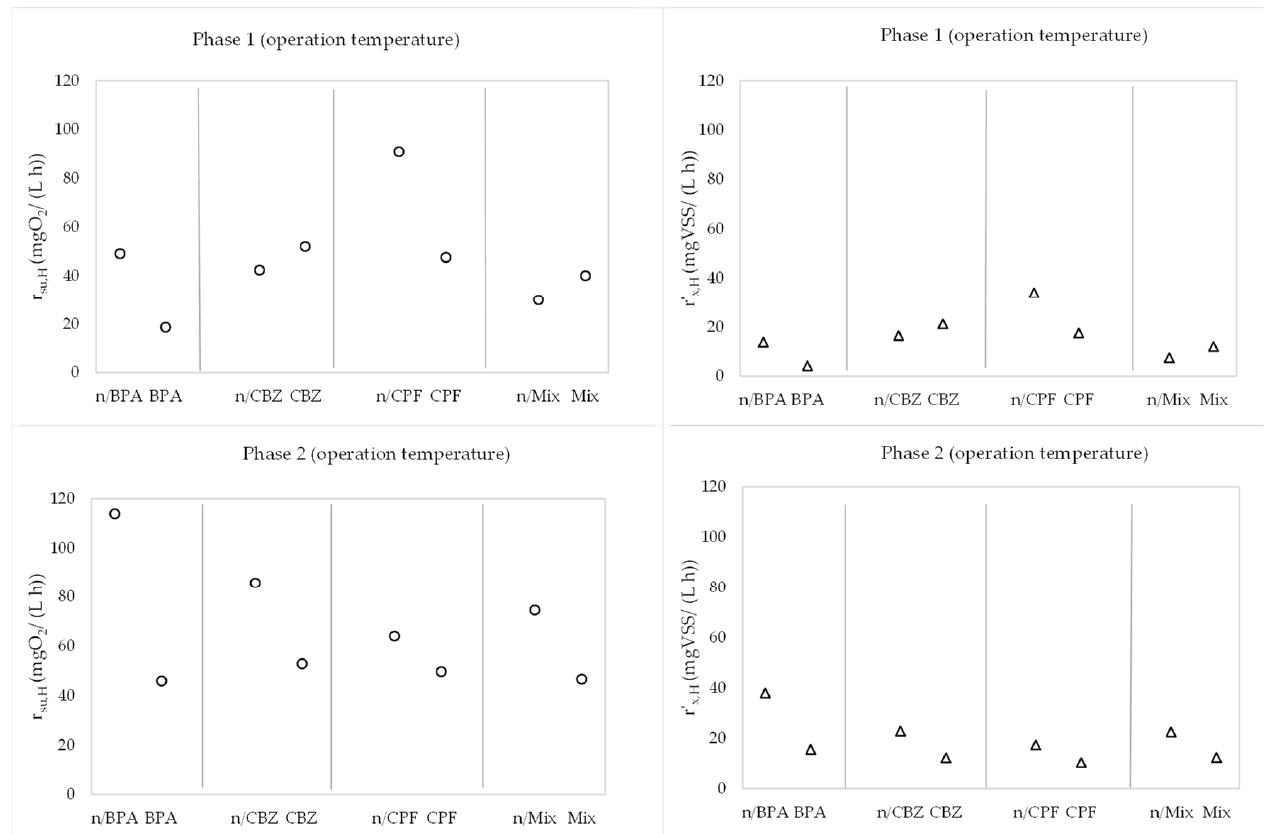
Figure 9. Evolution of r su,H ( ◦ ) and r ’x,H ( ∆ ) in phase 1 and phase 2 at operation temperature in plant. n/BPA: absence of bisphenol A. BPA: presence of bisphenol A. n/CBZ: absence of carbamazepine. CBZ: presence of carbamazepine. n/CPF: absence of ciprofloxacin. CPF: presence of ciprofloxacin. n/Mix: absence of mix of pharmaceuticals. Mix: presence of mix of pharmaceuticals.